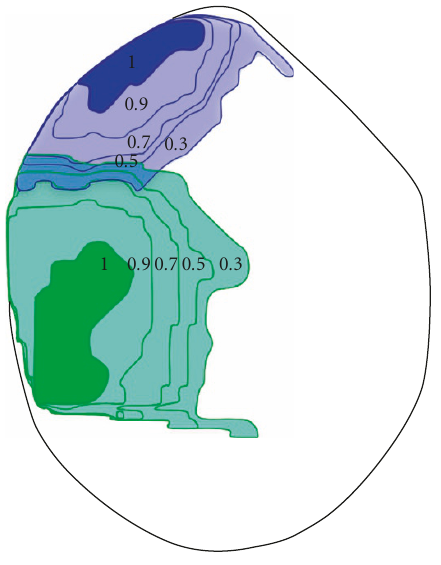
Figure 8: Level sets of the membership function in an equilumi- nance plan for the green and blue